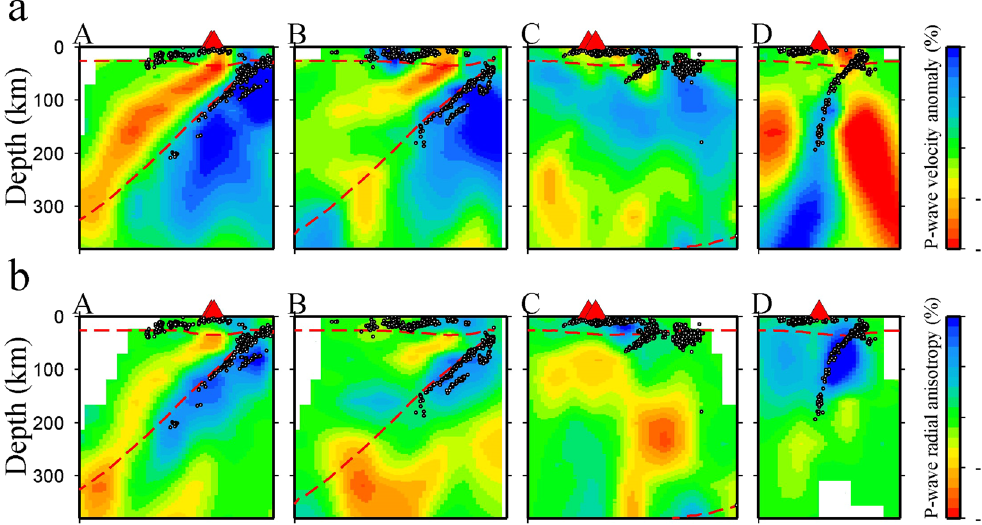
Figure 3. Vertical cross-sections of tomography along the four profiles shown in Fig. 1b. ( a ) Isotropic P-wave velocity images. ( b ) Images of P-wave radial anisotropy. The definitions of the color scales for the isotropic velocity anomaly and radial anisotropy amplitude are the same as those in Fig. 2. The red dashed lines show the Moho discontinuity 33, 35 and the upper boundary of the subducting Pacific slab 37, 38 , respectively. The red triangles and white dots denote active arc volcanoes and seismicity during a period of 2002–2007 within a 10 km width of each profile. This Figure is generated using GMT 4.5.3 (http://www.soest.hawaii.edu/gmt/) developed by Wessel and Smith 59